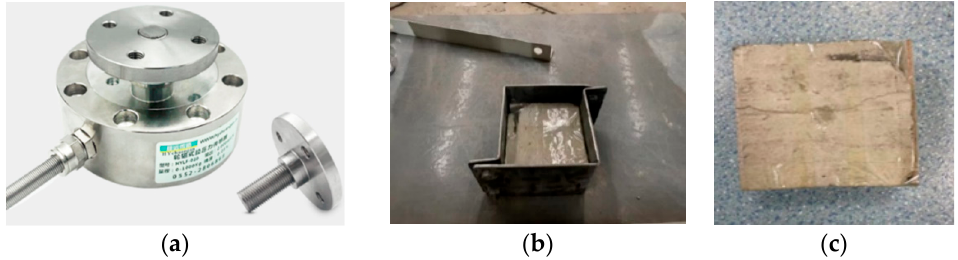
Figure 11. ( a ) Impact-load recorder; ( b ) concrete sample with restriction; ( c ) concrete sample after impact test. Table 2. The impact-test results of unburned concrete block.